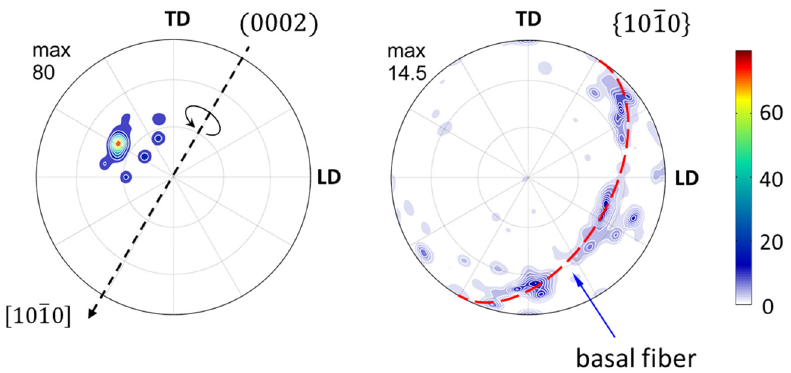
(cid:8) (cid:9) Figure 20. (0002) and (cid:4668)101(cid:3364)0(cid:4669) pole fi gures of the recrystallized grains, extracted from the orienta ‐ Figure 20. (0002) and 1010 pole figures of the recrystallized grains, extracted from the orientation tion map in Figure 8c. map in Figure